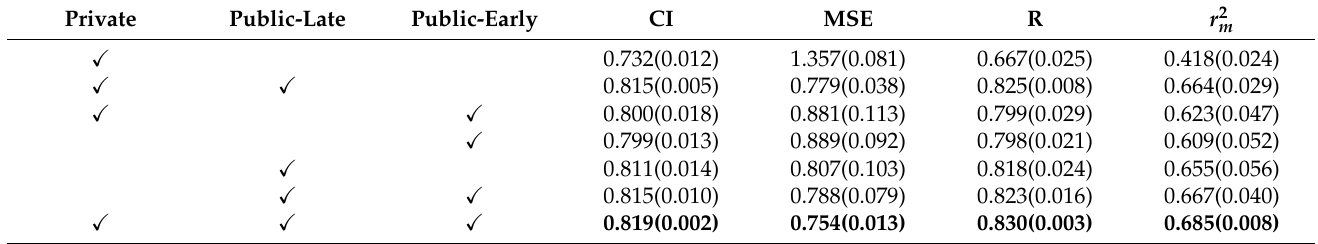
Table 4. Ablation experiment results obtained by the DMIL-PPDTA approach on the BindingDB dataset under the random splitting setting. The entries in boldface denote the best result for each metric, and the data in brackets represent standard